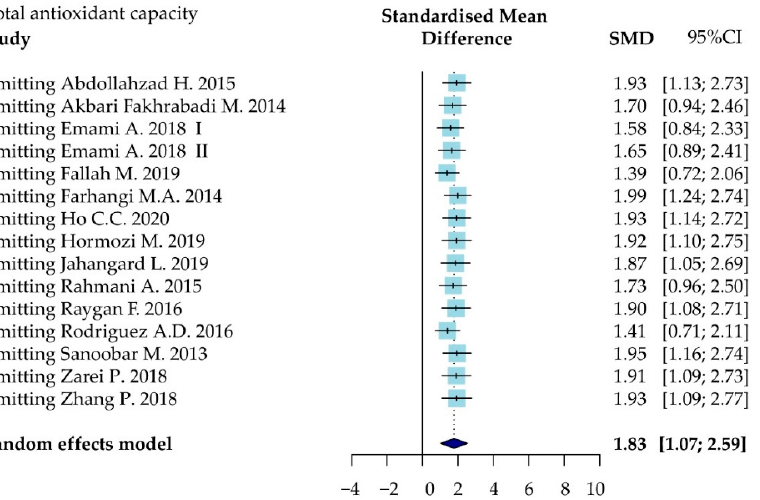
Figure A1. Risk of bias assessment for the included studies. Trials with a low or high risk of bias in key domains were categorized as having a “low risk of bias” or “high risk of bias”, respectively. Otherwise, trials were categorized as having an “unclear risk of bias”.